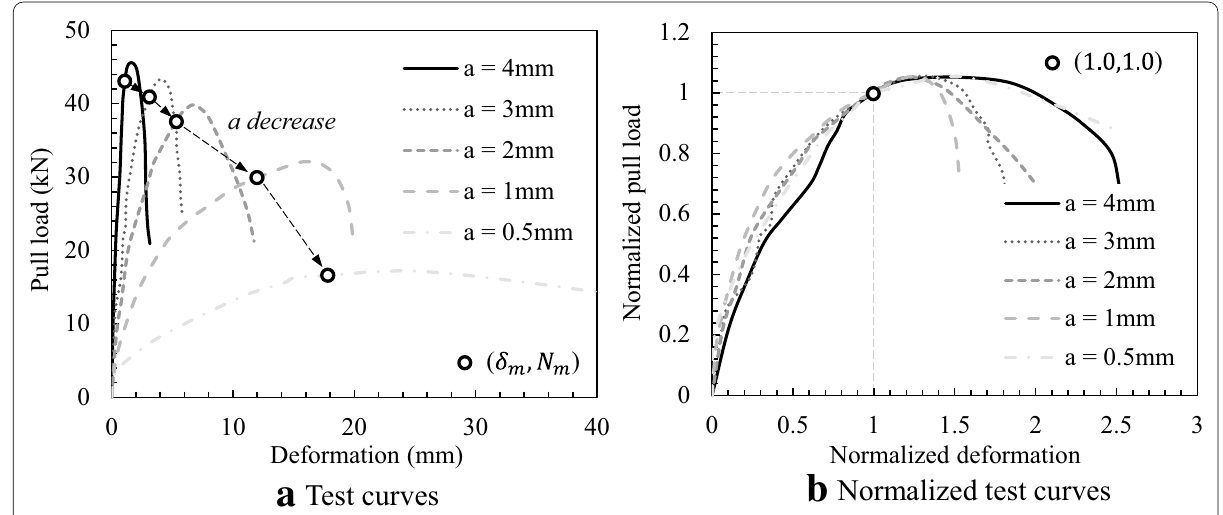
Fig. 11 Typical load–deformation curves of anchorage concrete with extremely small bearing